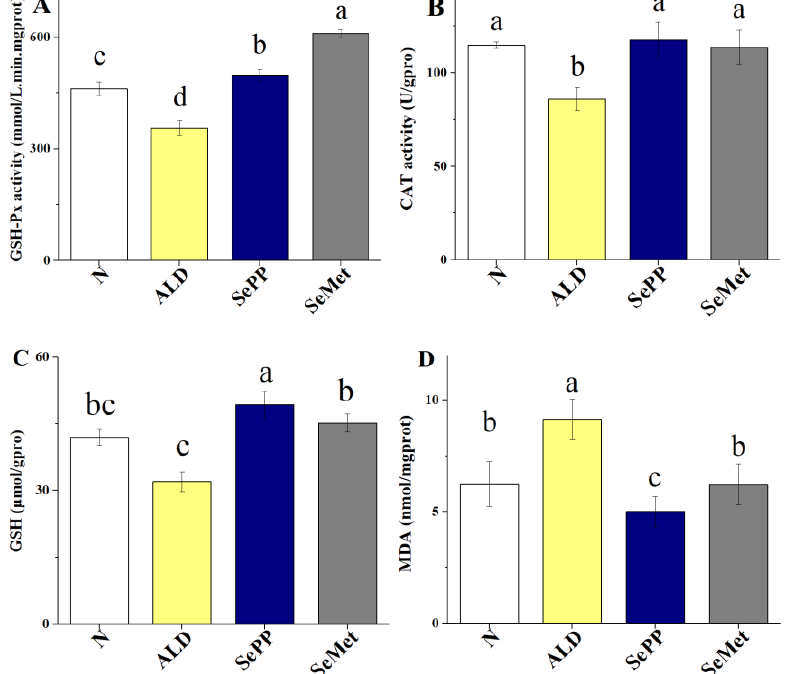
Figure 6. Oxidative damages in mice. Levels of serum GSH-Px activity ( A ), liver CAT activity ( B ), liver GSH depletion ( C ) and MDA generation ( D ) are shown. Different letters denote significant differences between groups ( p <